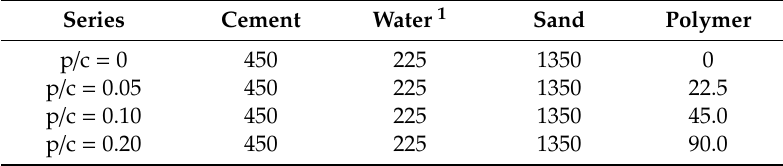
Table 3. Mixture compositions (in